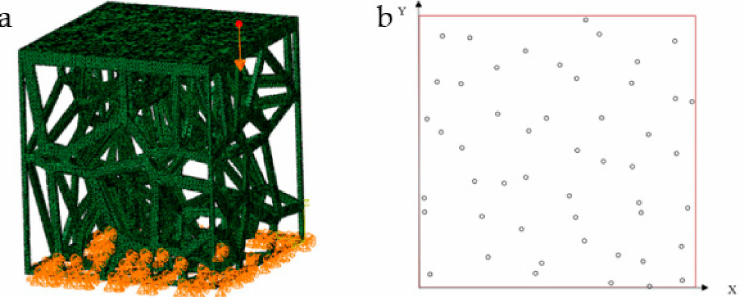
Figure 11. Schematic diagram of FEA: ( a ) The vertical force is applied to one of the 50 points; ( b ) Positions of 50 random points.